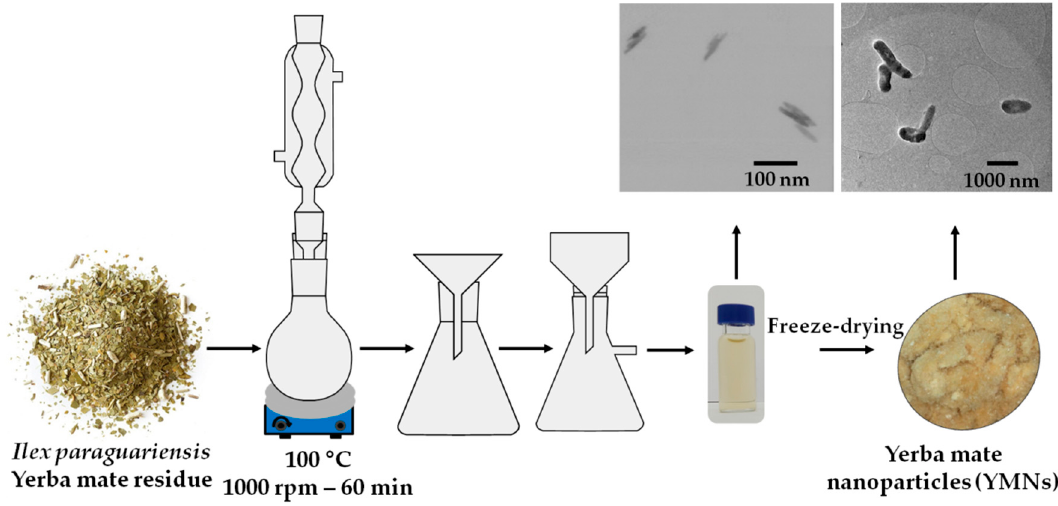
Figure 1. Schematic representation of mate nanoparticles’ extraction procedure.